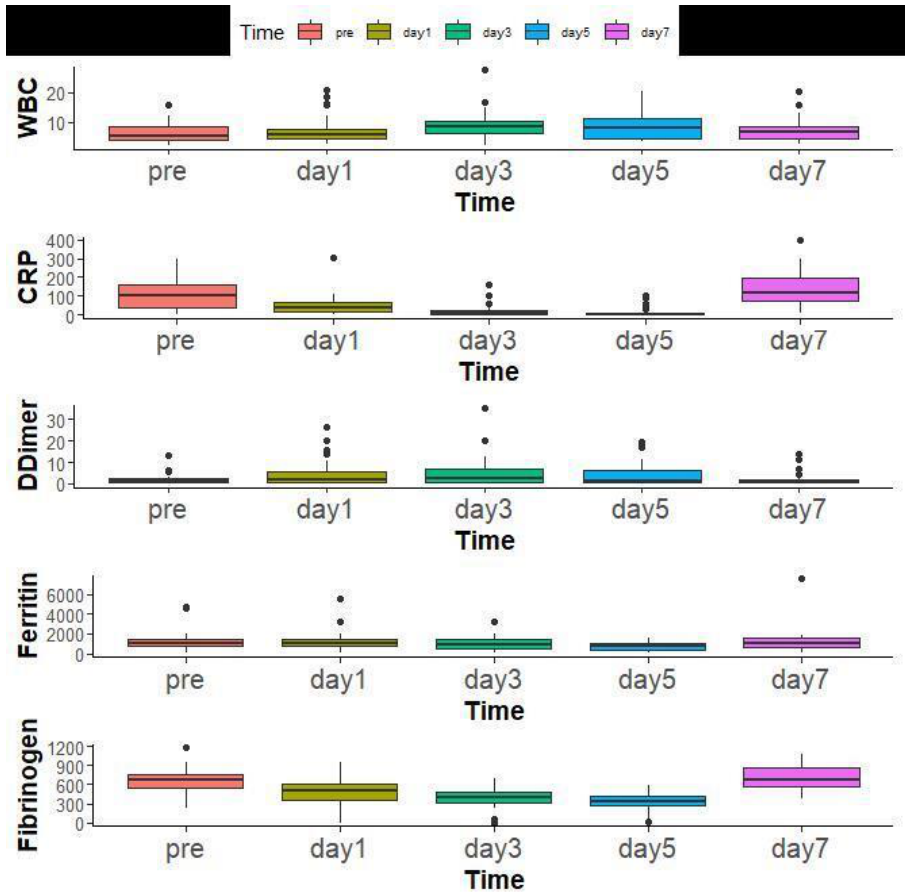
Figure 6. Laboratory findings of all patients overtime before Tocilizumab administration and at days 1, 3, 5, and 7.